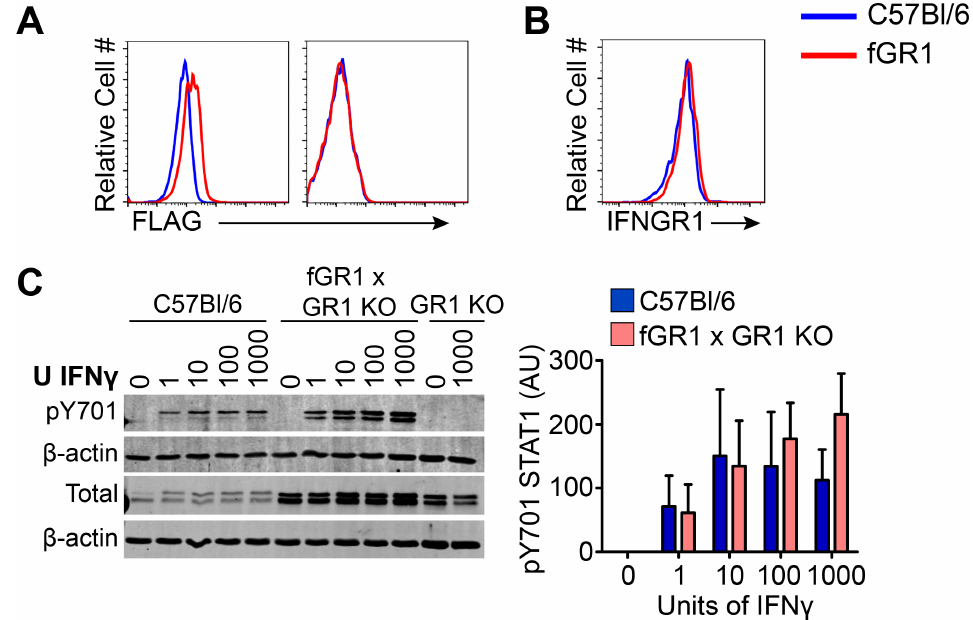
Fig 1. fGR1 expression is low and restrictedto macrophages. Na ï veperitonealcells were isolatedfrom WT C57Bl/6 (Blue) and fGR1+ (Red) mice. A) FLAG expressionwas analyzedon both macrophage (CD90.2 -, CD11b hi , F480 hi ) (Left) and T cell (CD90.2+) (Right) populationsby flow cytometry. B) Surface expressionof IFNGR1 on unstimulated na ï veperitonealmacrophages from both mouse genotypes. C) Na ï veperitoneal macrophagesfrom C57Bl/6, fGR1 x GR1 KO, or B6. ifngr1 -/- (GR1 KO) mice were stimulatedwith increasing concentrations of IFN γ for 30 min. Phosphorylation of Y701 STAT1 was detected by immunoblot. Graph depicts density of pSTAT1 bands normalized to the loadingcontrol β -actin, Arbitrary Units (AU). (n = 3 independent experiments).